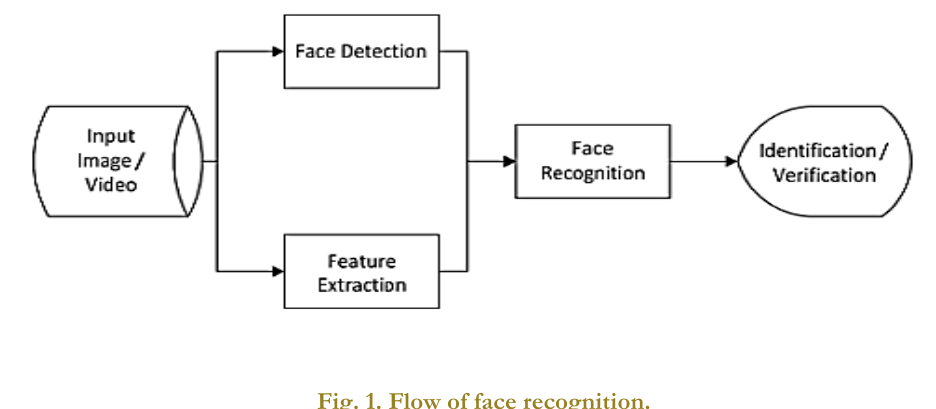
Fig. 1. Flow of face